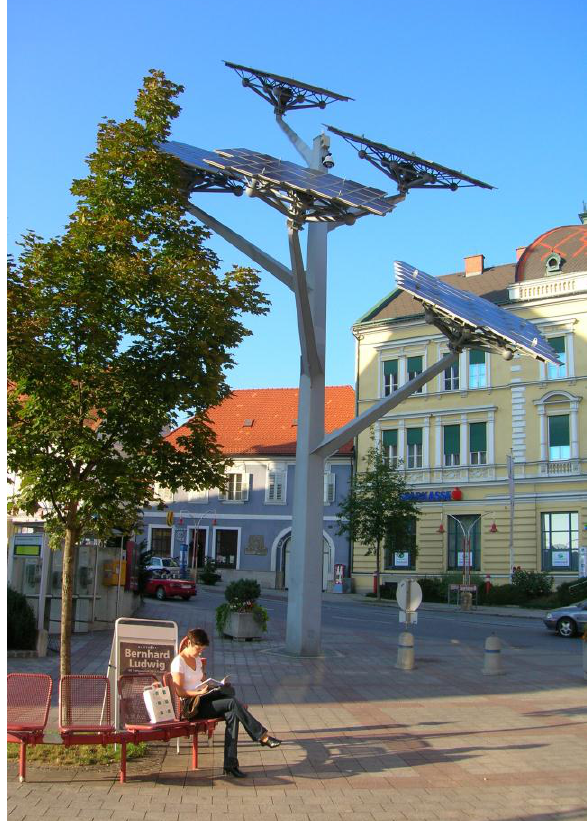
Figure 6. The team is evaluating a design similar to the solar tree in Gleisdorf, Austria